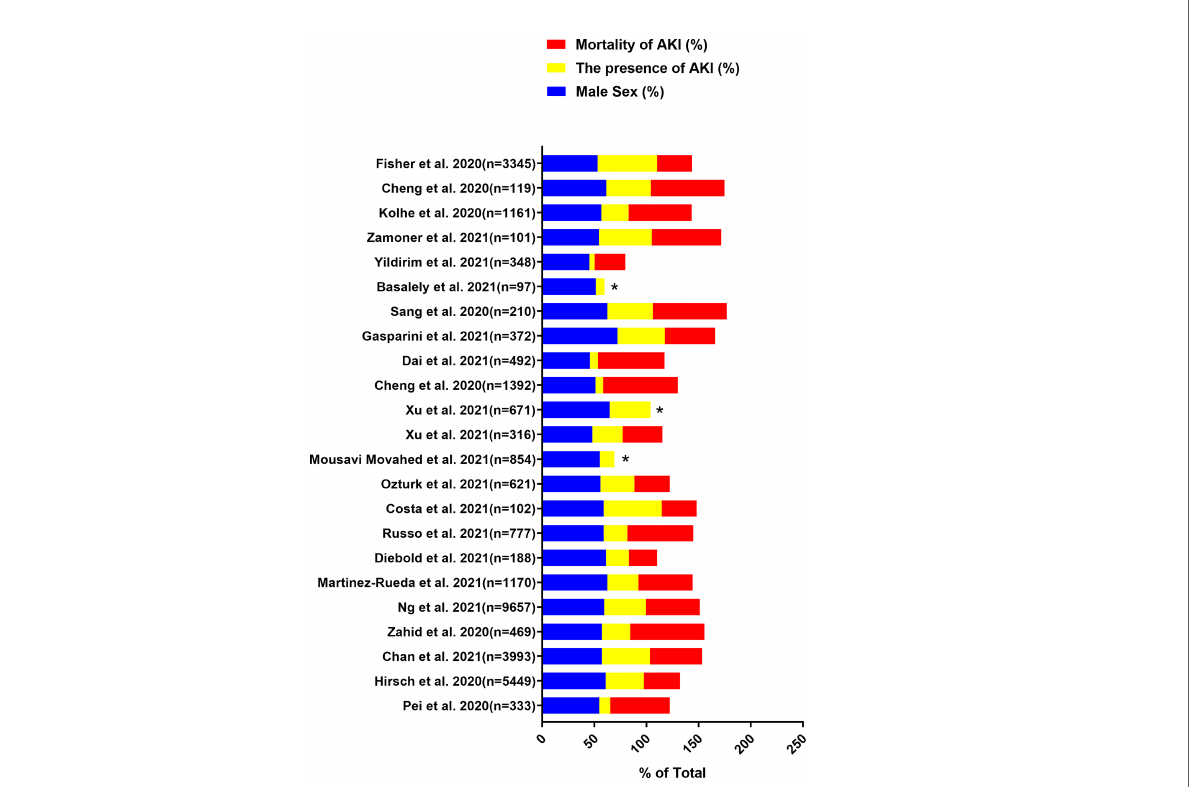
FIGURE 1 | Data are extracted from 23 studies on COVID-19 patients, including the total number of patients included, the proportion of male patients, the incidence of AKI and the mortality of AKI. “ * ” : The mortality of AKI is